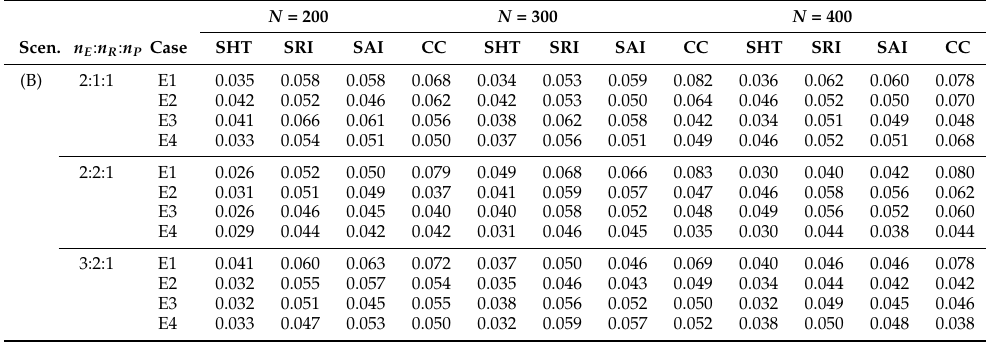
Table A2. Empirical Type I error rates for Scenarios (B) and (C) with unbalanced designs. N = 200 N = 300 N =